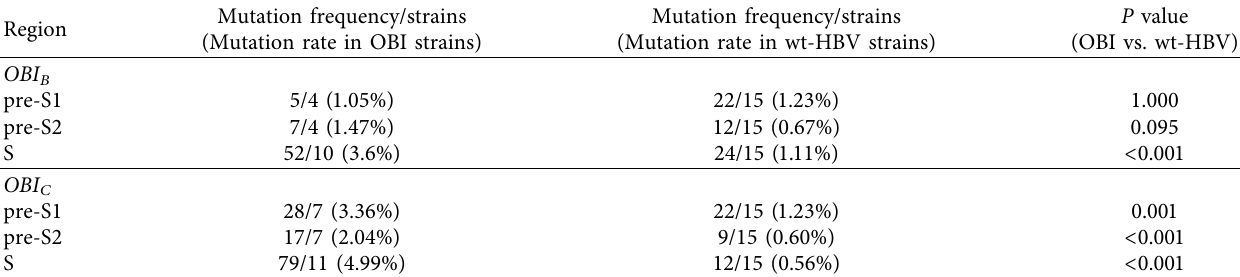
Table 2: The amino acids substitutions of envelope protein in OBI strains compared with wild-type HBV strains. Mutation frequency/strains Mutation frequency/strains Region